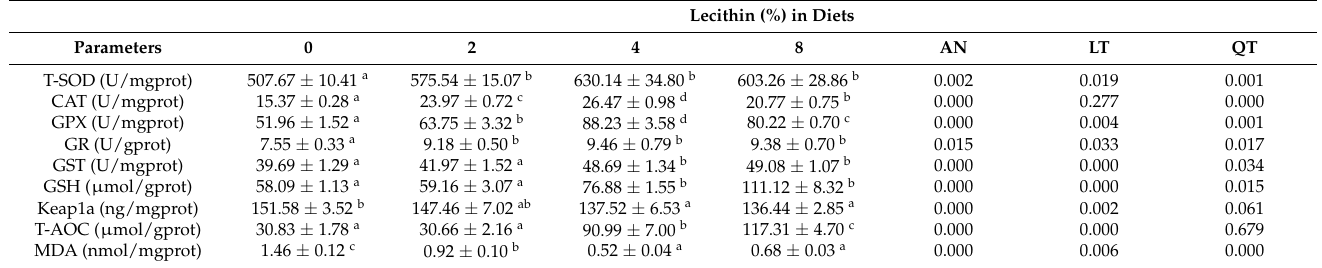
Table 4. E ff ects of dietary soybean lecithin on the antioxidative and oxidative indices in the liver of largemouth bass. Lecithin ( % ) in Diets